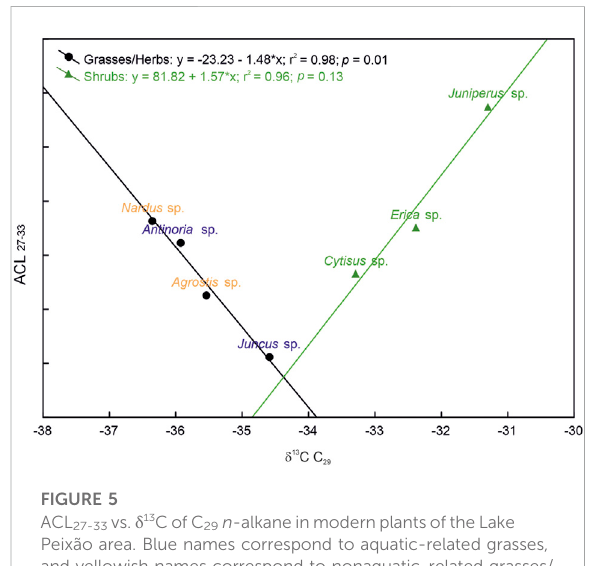
FIGURE 5 ACL 27-33 vs. δ 13 CofC 29 n -alkaneinmodernplantsoftheLake Peixão area. Blue names correspond to aquatic-related grasses, and yellowish names correspond to nonaquatic-related grasses/ herbs